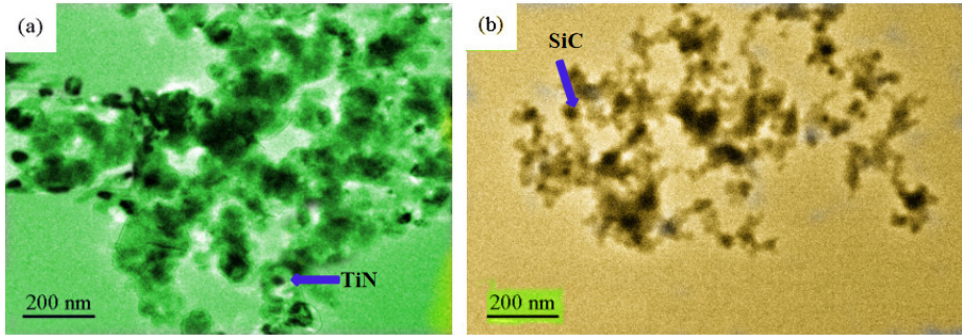
Figure 2. TEM micrographs for the products: ( a ) TiN, and ( b ) SiC nanoparticles.